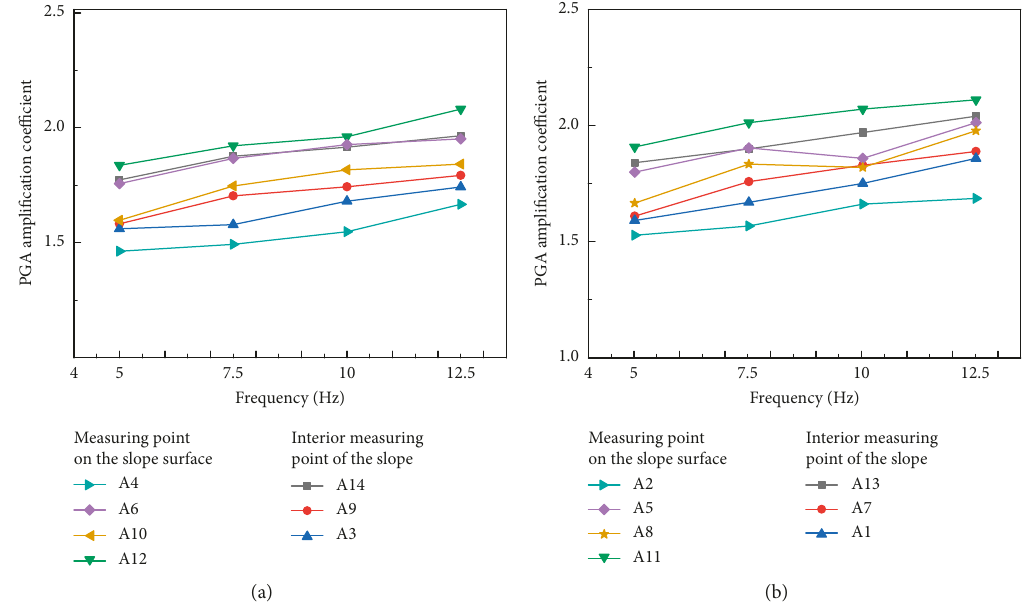
Figure 20: (a) PGA amplification coefficients of convex slope under sine waves with different frequencies. (b) PGA amplification coefficients of concave slope under sine waves with different